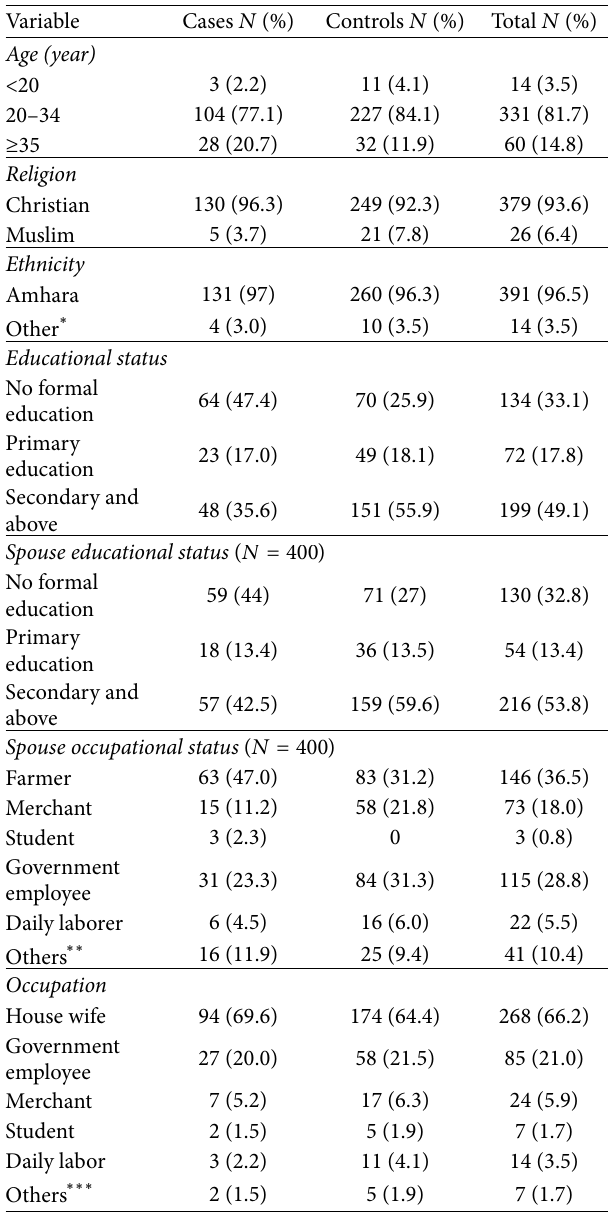
Table 1: Socio-demographic characteristics of study participants who gave birth in Amhara region, referral hospitals, Northwest, Ethiopia, 2018 ( 𝑛 = 405